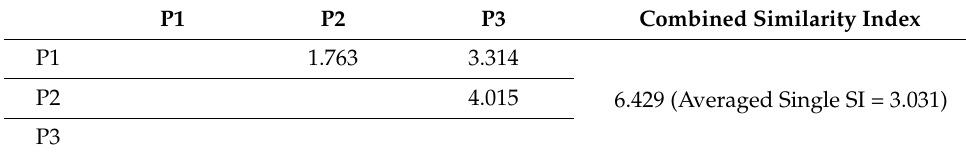
Table 6. Case-B Similarity Index (SI). Case-B calculated SI utilizing Equation